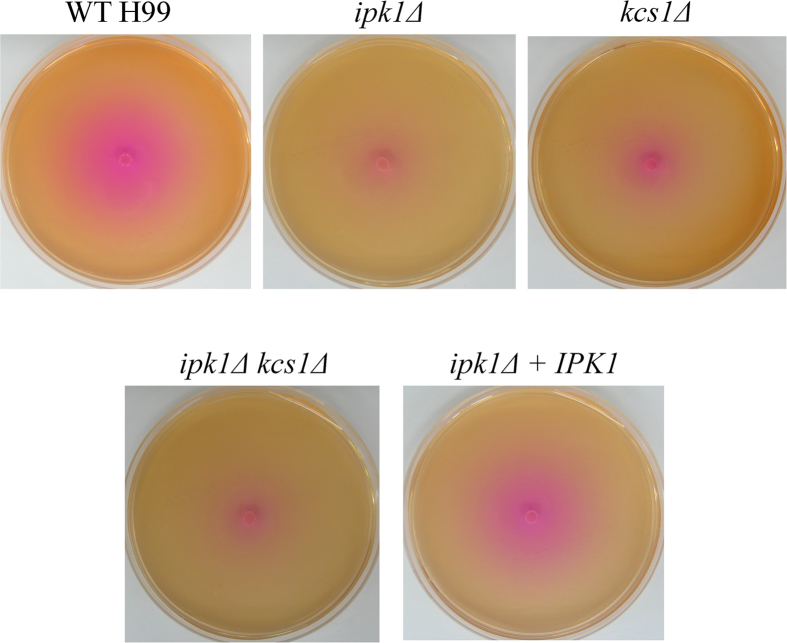
Effect of IPK gene deletion on urease production 106 cells of each strain was dropped onto Christensen’s (urea-containing) agar.All plates were incubated at 30 °C for 72 hours. The extent of urease production, which is observed due to the incorporation of the phenol red pH indicator, is proportional to the diameter of the pink halo surrounding the inoculum.